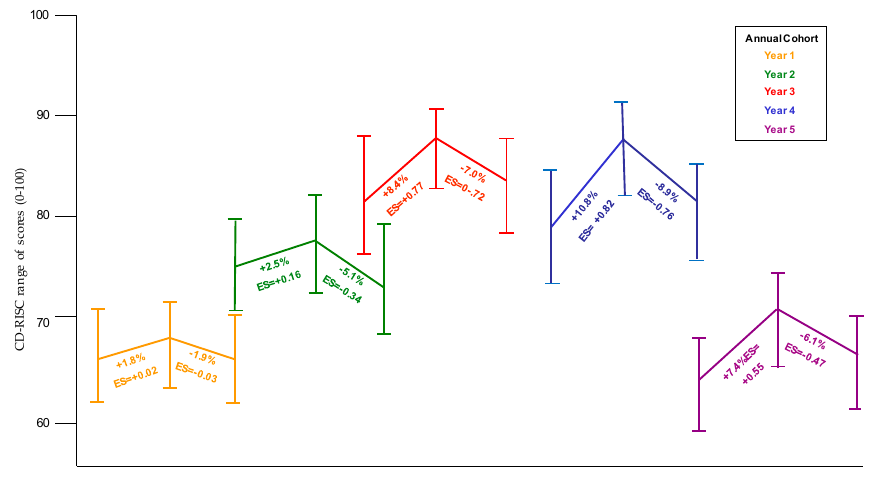
Figure 3. Pre (T1), post (T2) and follow-up (T3) mean Total Resilience by annual cohort (LOCF Data